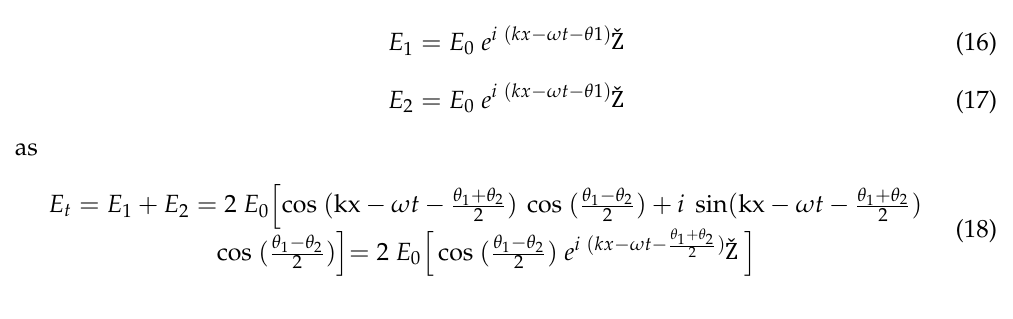
Figure 5. Schematics of the antenna in [43] with metamaterial and return loss. Reprinted from Ref. [43].